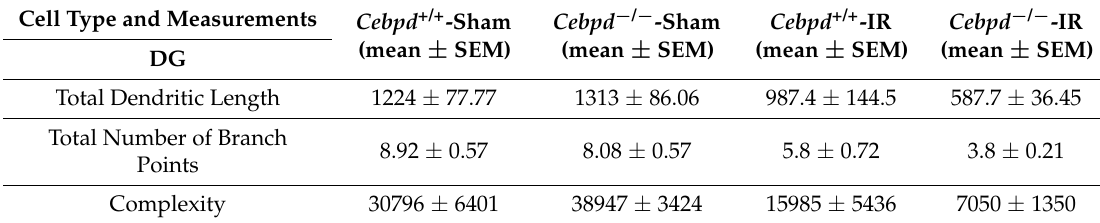
Table 1. Analysis of dendritic morphology of dentate gyrus (DG) granule neurons in aged Cebpd +/+ and Cebpd − / − mice. **** Bold figures represent significant compared to Cebpd − / − -IR. Cell Type and